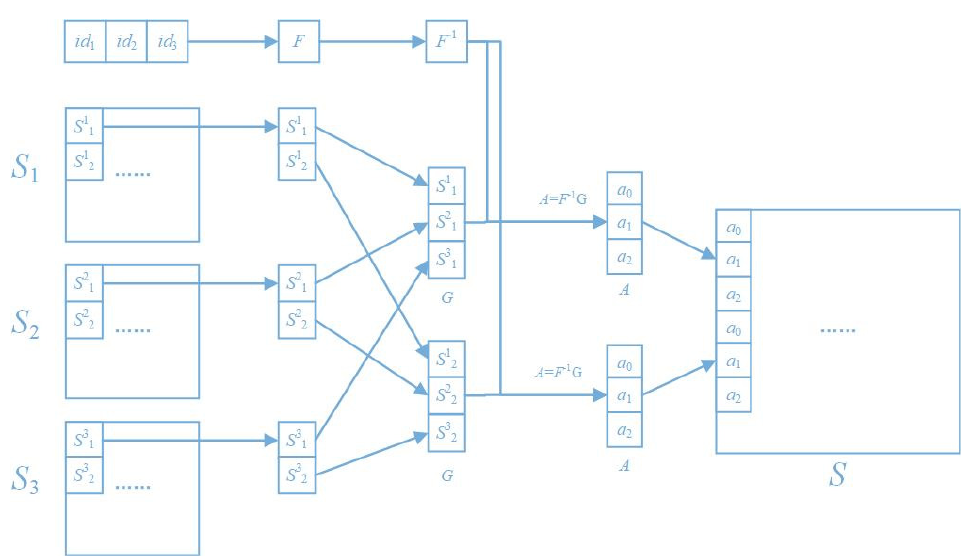
Figure 2. The schematic diagram of the recovery process.